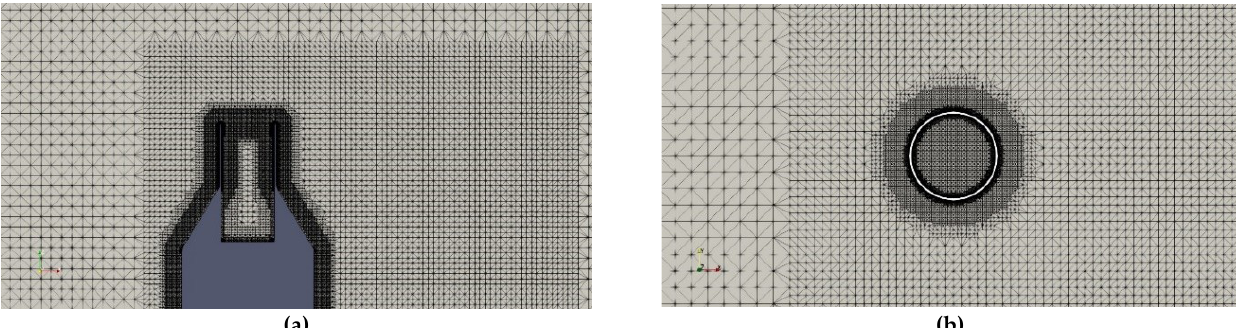
Figure 3. (a) Refinement region around the Geonor gauge body in the central vertical section ( x , z plane at y = 0) and (b) gradual refinement close to its surface in the horizontal section at the gauge collector elevation ( x , y plane at z = −2 m).